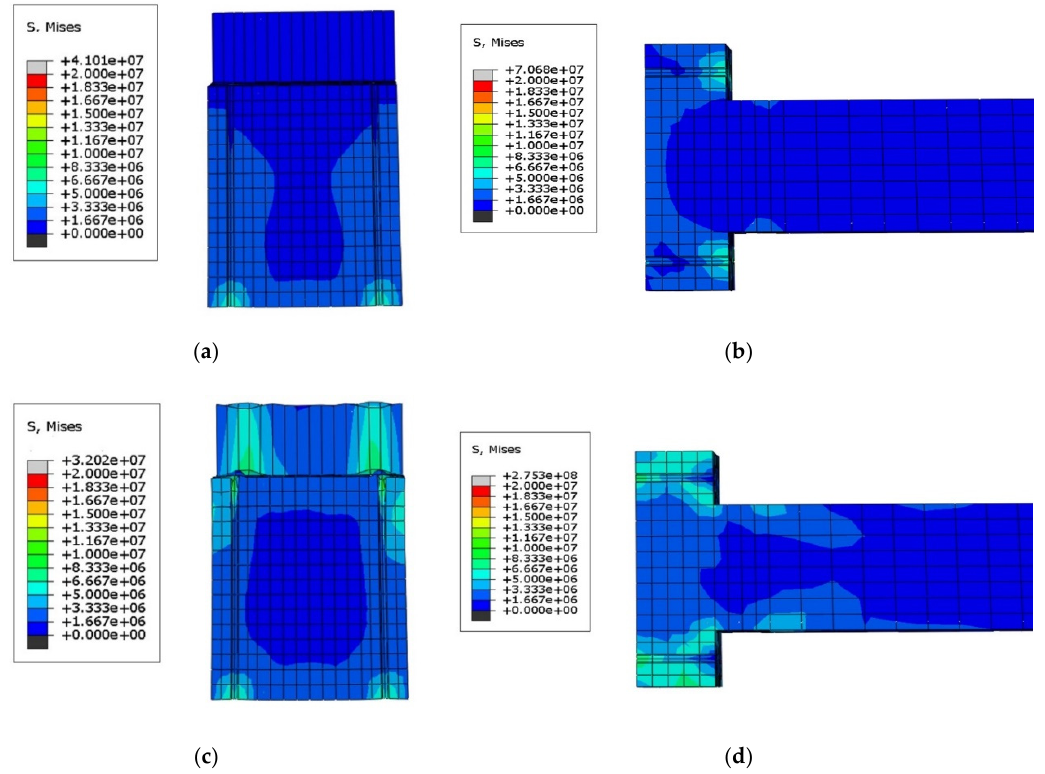
Figure 27. Stress cloud of the specimen J1 bolt-hole section: ( a ) − 20 mm stage column core section; ( b ) − 20 mm stage beam expanded end section; ( c ) − 60 mm stage column core section; ( d ) − 60 mm stage beam expanded end section.